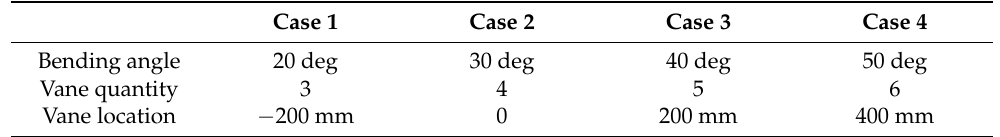
Table 2. Classification groups of the pressure drop